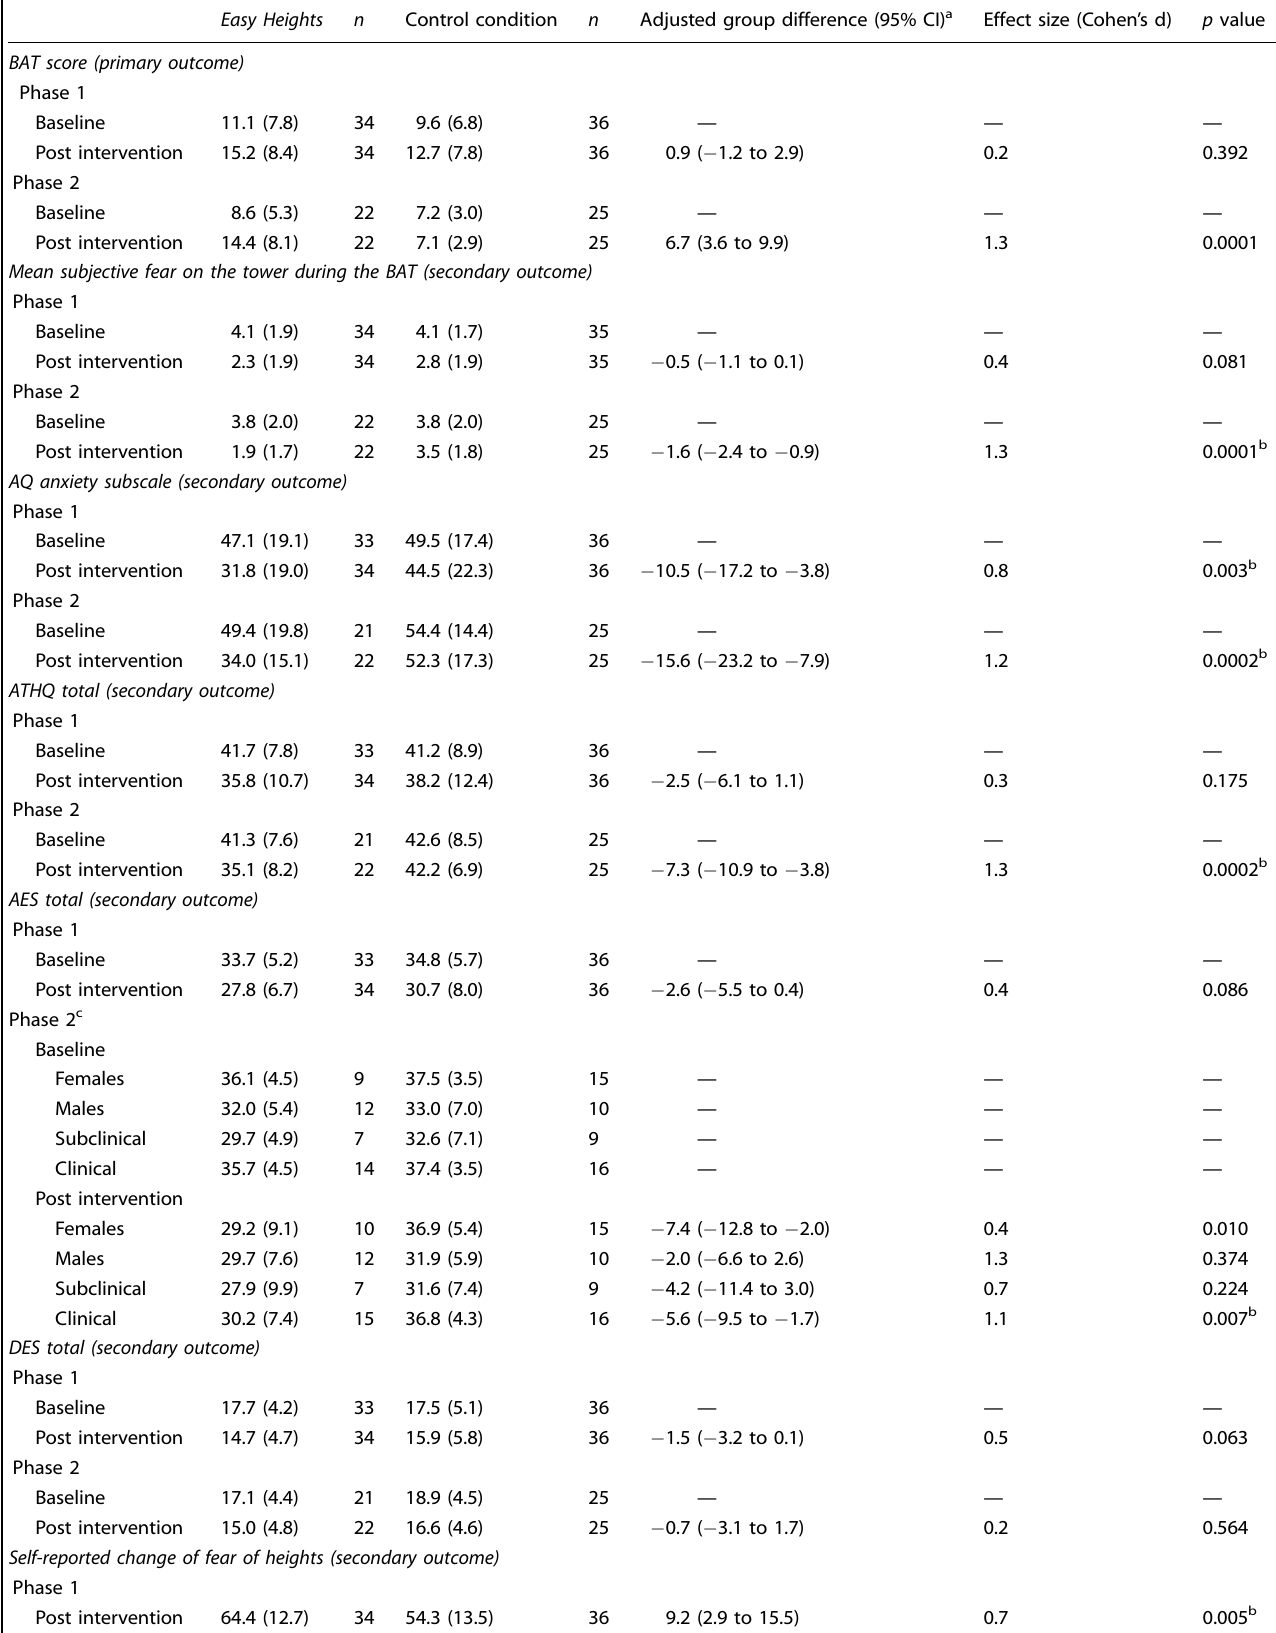
Table 2. Outcome measures and differences between conditions. Easy